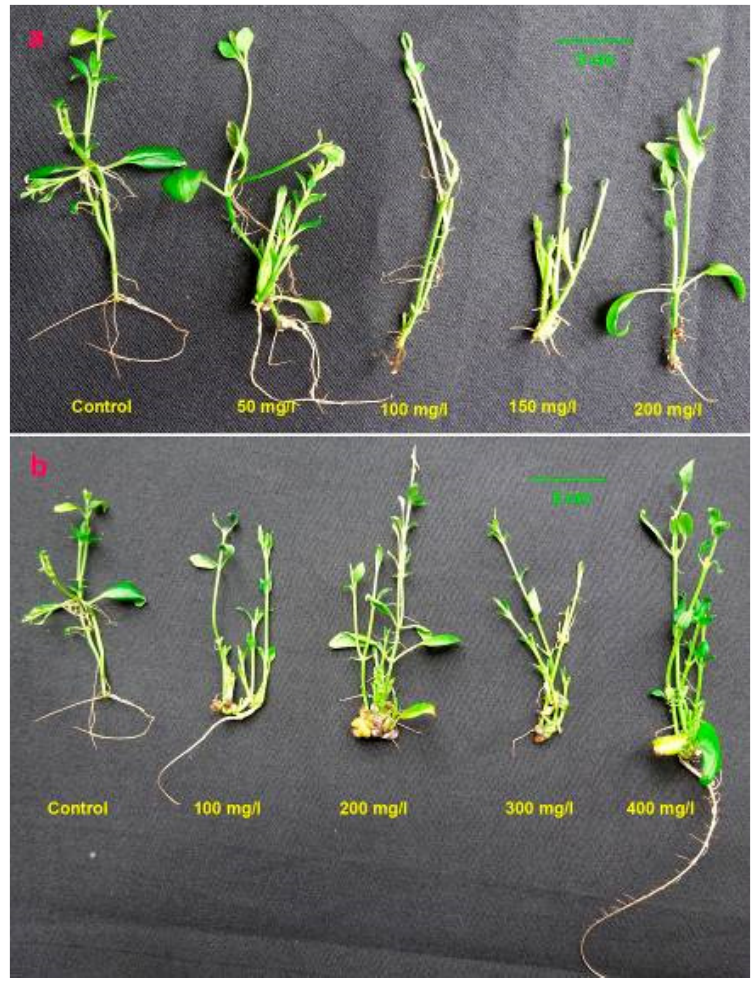
Figure 1. Morphogenic responses of the in vitro shoots of C. nutans in different concentrations of